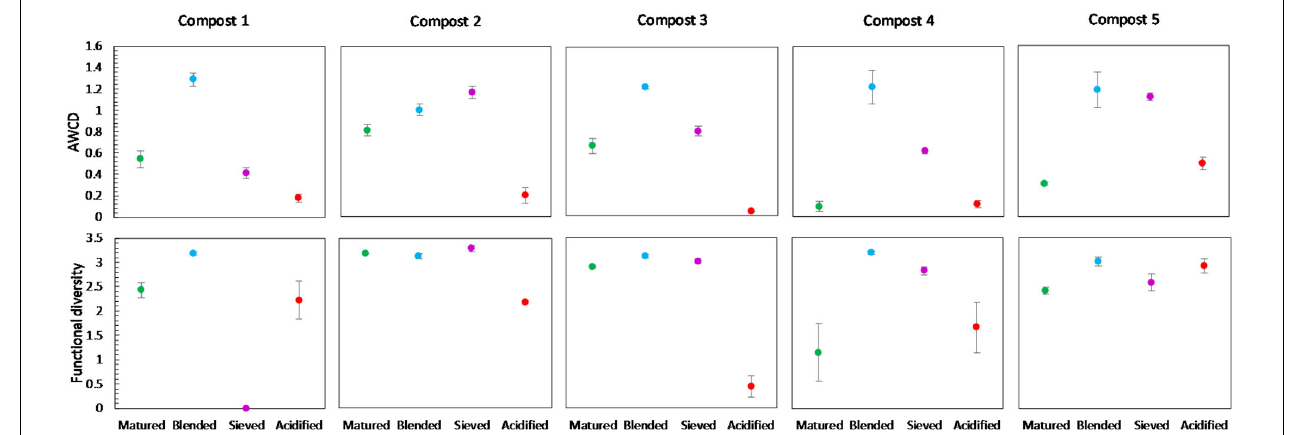
FIGURE 9 | Metabolic characteristics of matured, blended, sieved and acidified composts in the five compost batches. On top: mean metabolic activity ± standard error in the five compost batches, expressed as mean AWCD (average well color development). Below: mean functional diversity ± standard error in the five compost batches, calculated as the Shannon diversity index from the Biolog Ecoplates